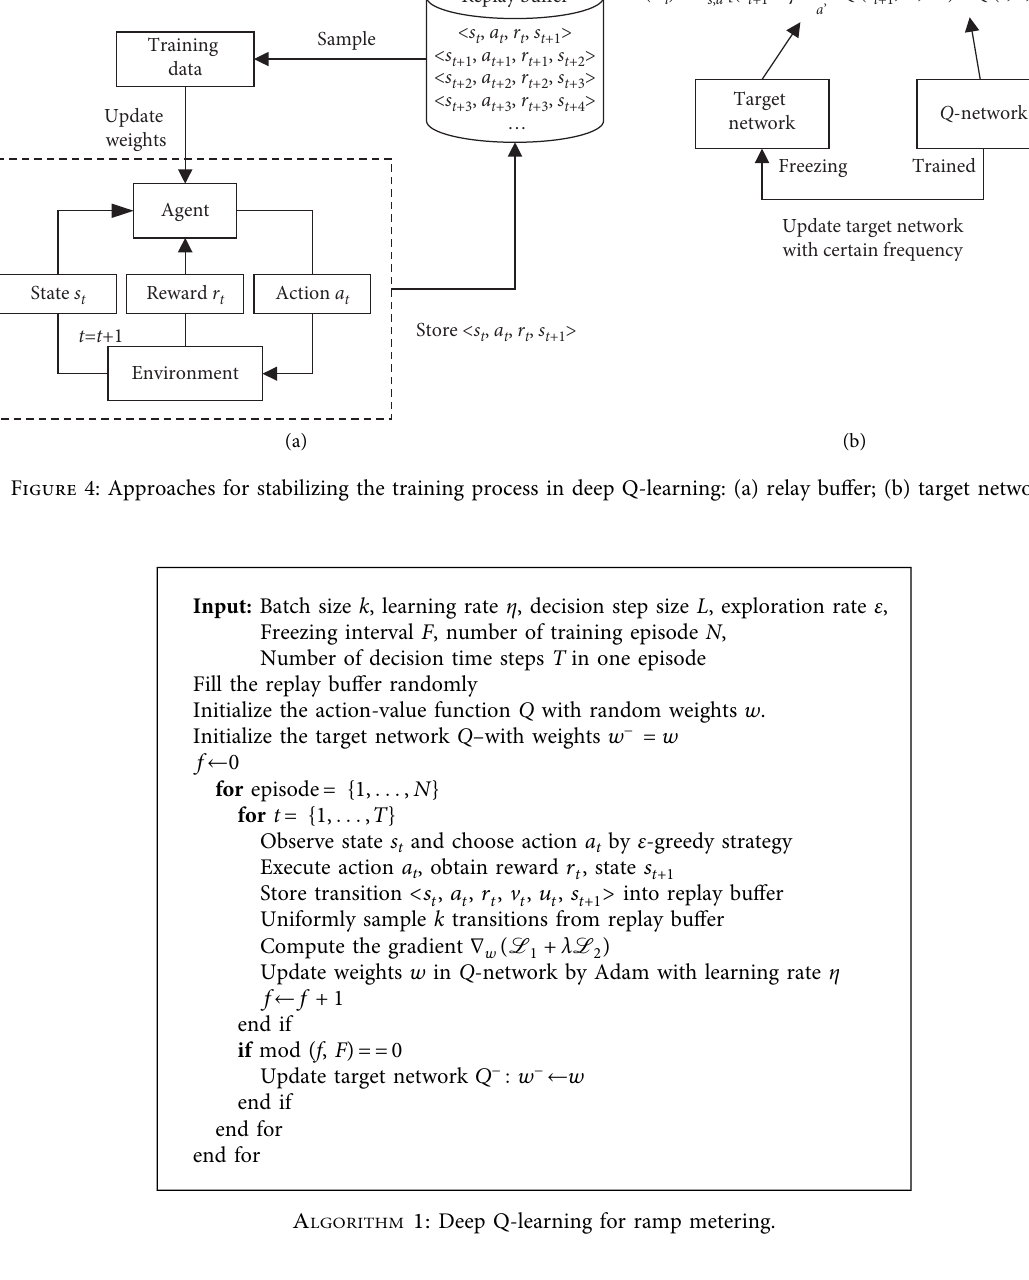
on empirical data. The simulation time is 7:50 a.m. to 9:00 a.m. Figure 6 presents the 10-min traffic volumes from 7:50 a.m. to 9:00 a.m. in the mainline and at the on-ramp. The agent’s observation in DRL covers the simulated road network. Three consecutive frames of the traffic video in the controlled area are needed as the observation input of each decision time step. After zooming and down-sampling, the size of one observation is 4 × 512 in pixels. Three consecutive observations are stacked to represent the traffic state. To accommodate the input size for ramp metering, the Q-network in Mnih et al. [30] is revised as Figure 7, which consists of three convolutional neural network (CNN) layers and one full connection (FC) layer for each output layer.